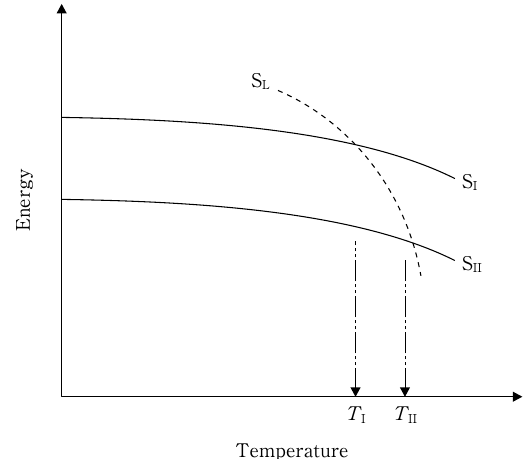
Fig. 2 Hypothetical energy diagram of a monotropic system ( T I and T II : melting points of Forms I and II; T t : transition